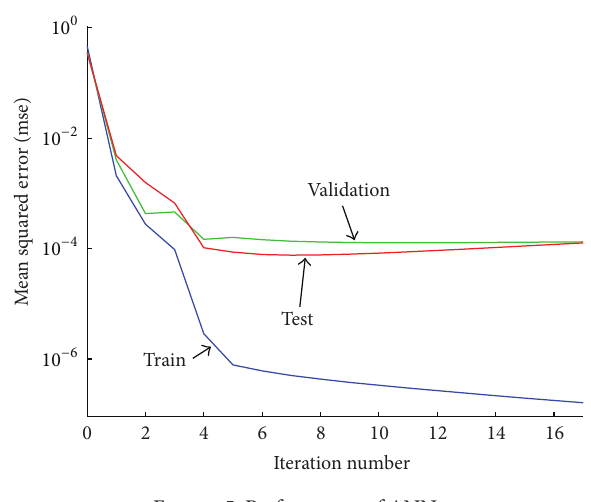
Figure 5: Performance of ANN. Table 4: Maximum and average of errors of ANN results for all